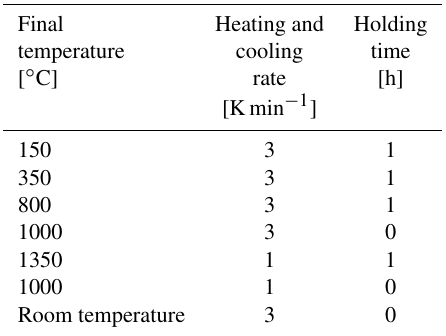
Table 3. Sintering schedule of the L(XG)S and L(3G)S_33Sr pel- lets.